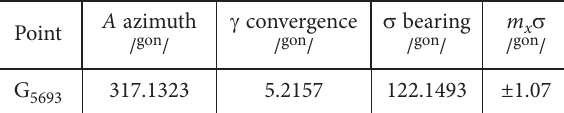
Table 6. Resulting orientation measurement values